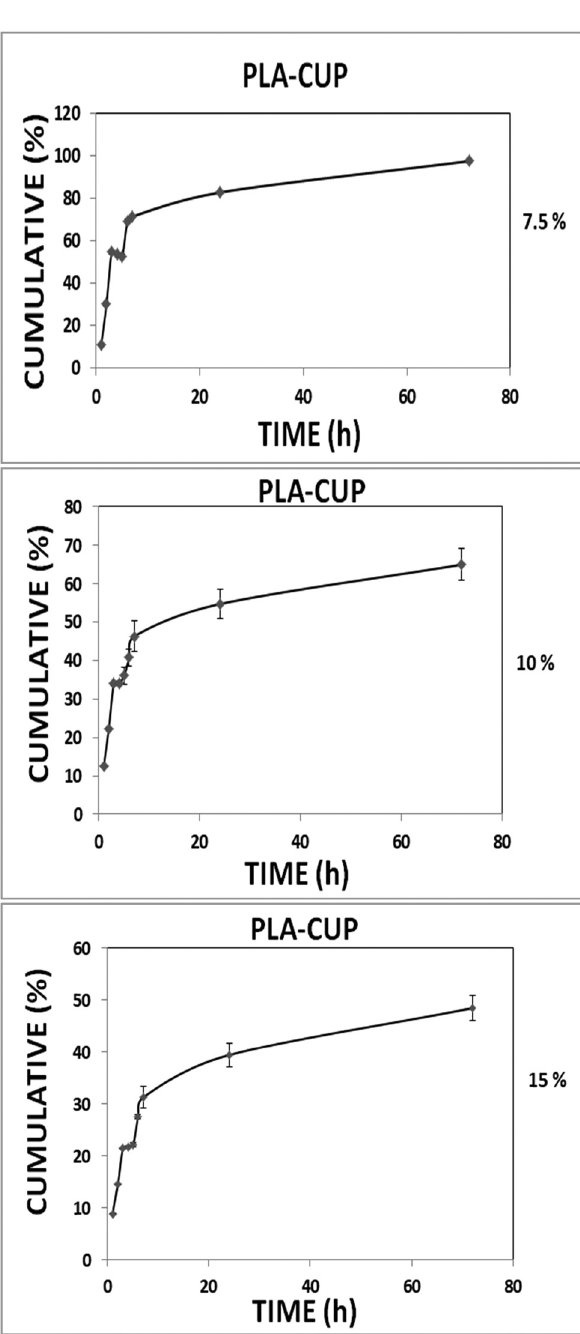
Figure 5: Releasing behavior of the di ff erent amount ( 7.5, 10, and 15% ) of cypress EO